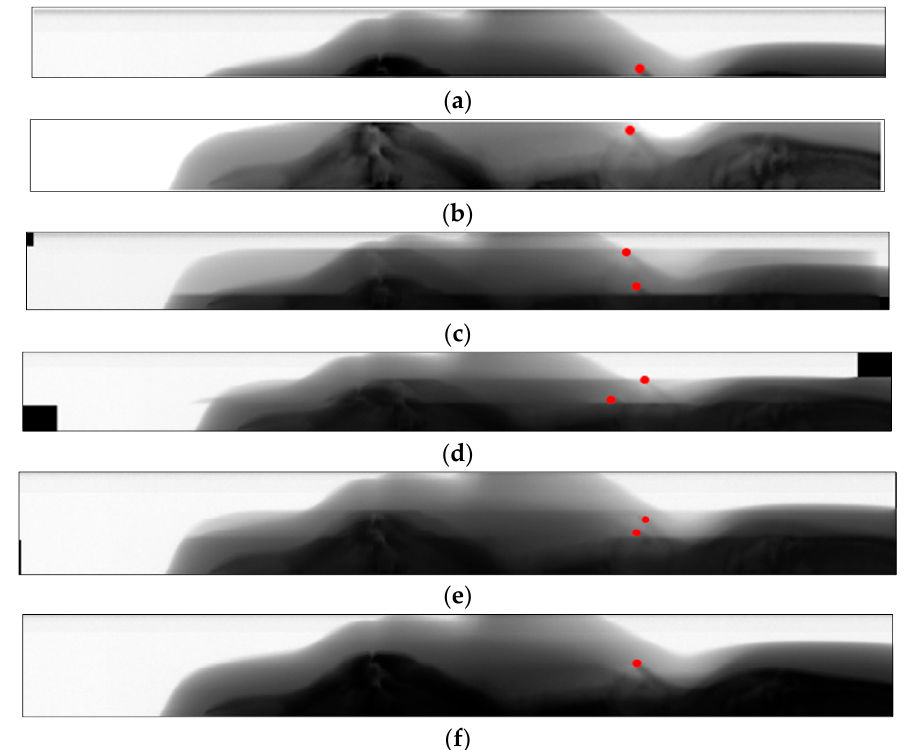
Figure 14. Error observation of registration. ( a ) Image 1 to be stitched, ( b ) Image 2 to be stitched, ( c ) NCC, ( d ) LSS-MI, ( e ) SIFT-PC, ( f ) this article.